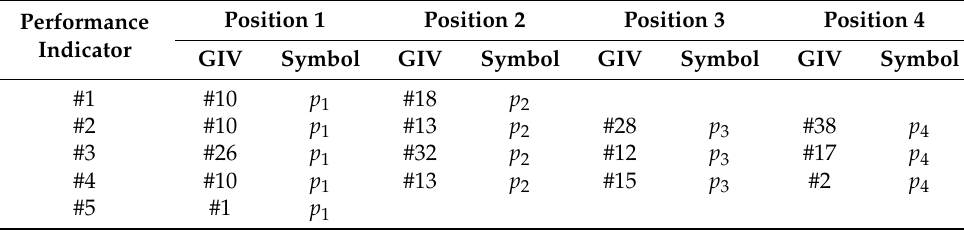
Table 2. Order of